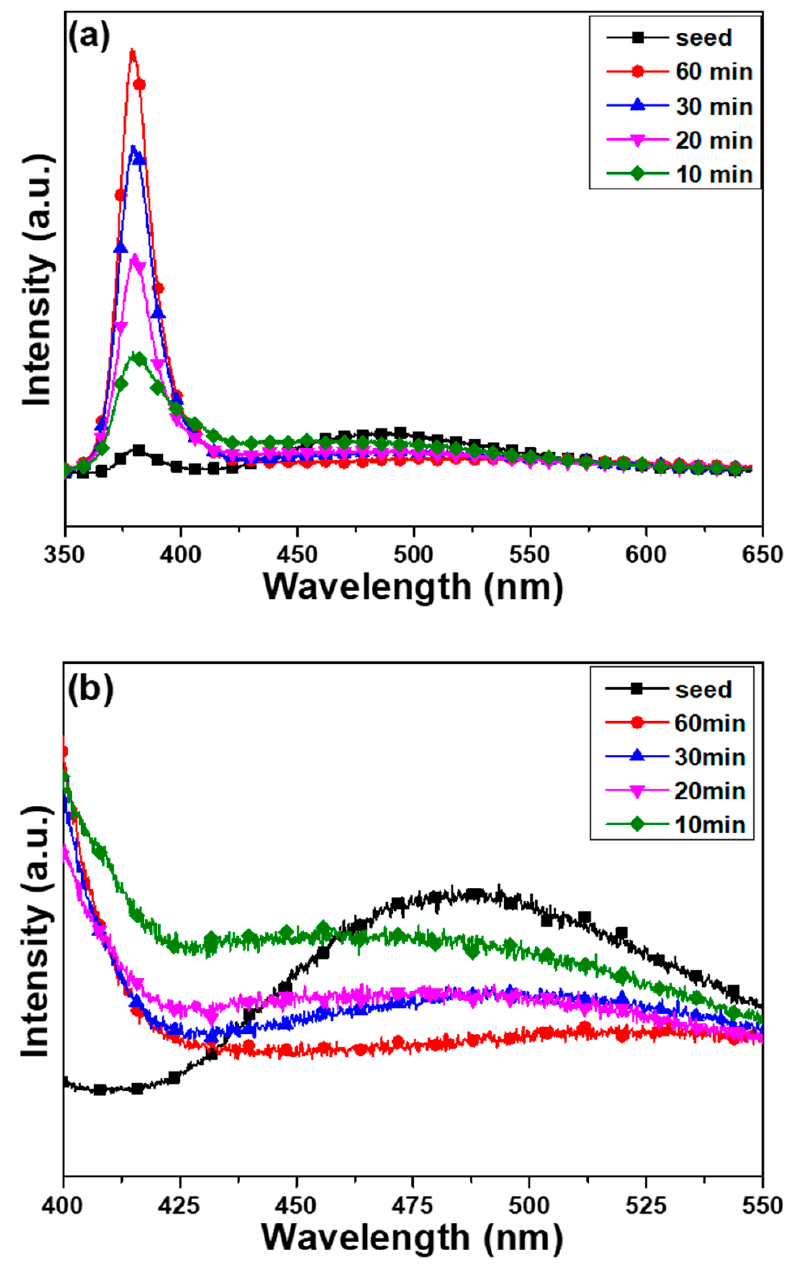
Figure 9. The PL spectra of the ZnO seed layer and ZnO nanoflower arrays on the SC-B substrate as a function of synthesis time: ( a ) in the wide range of 350–650 nm and ( b ) in the narrow range of 400–550 nm.